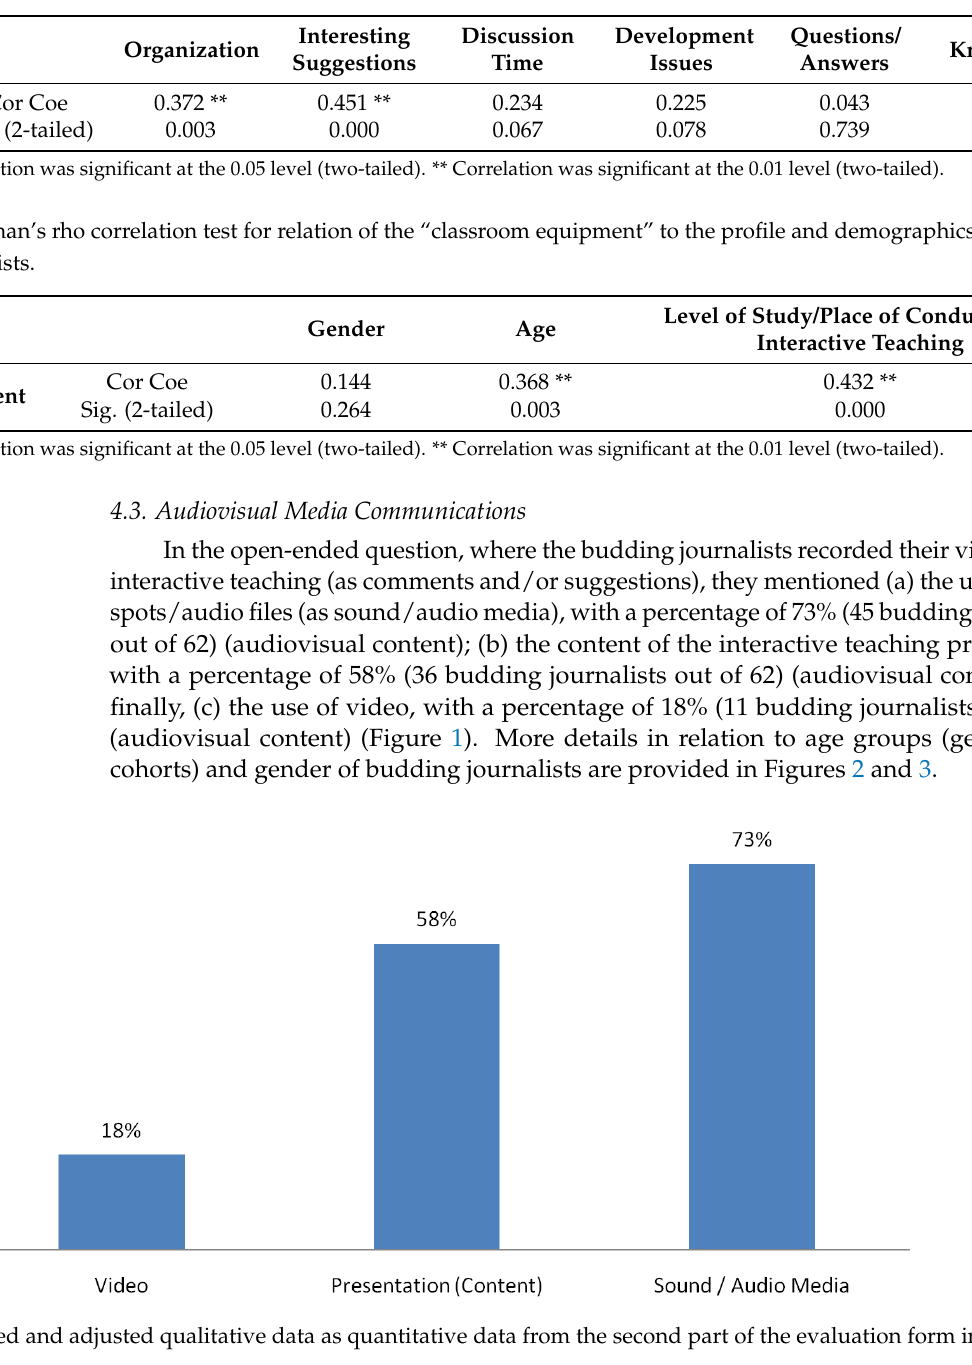
Figure 2. Grouped and adjusted qualitative data as quantitative data from the second part of the evaluation form in three categories of budding journalists based in age groups (genealogical cohorts).